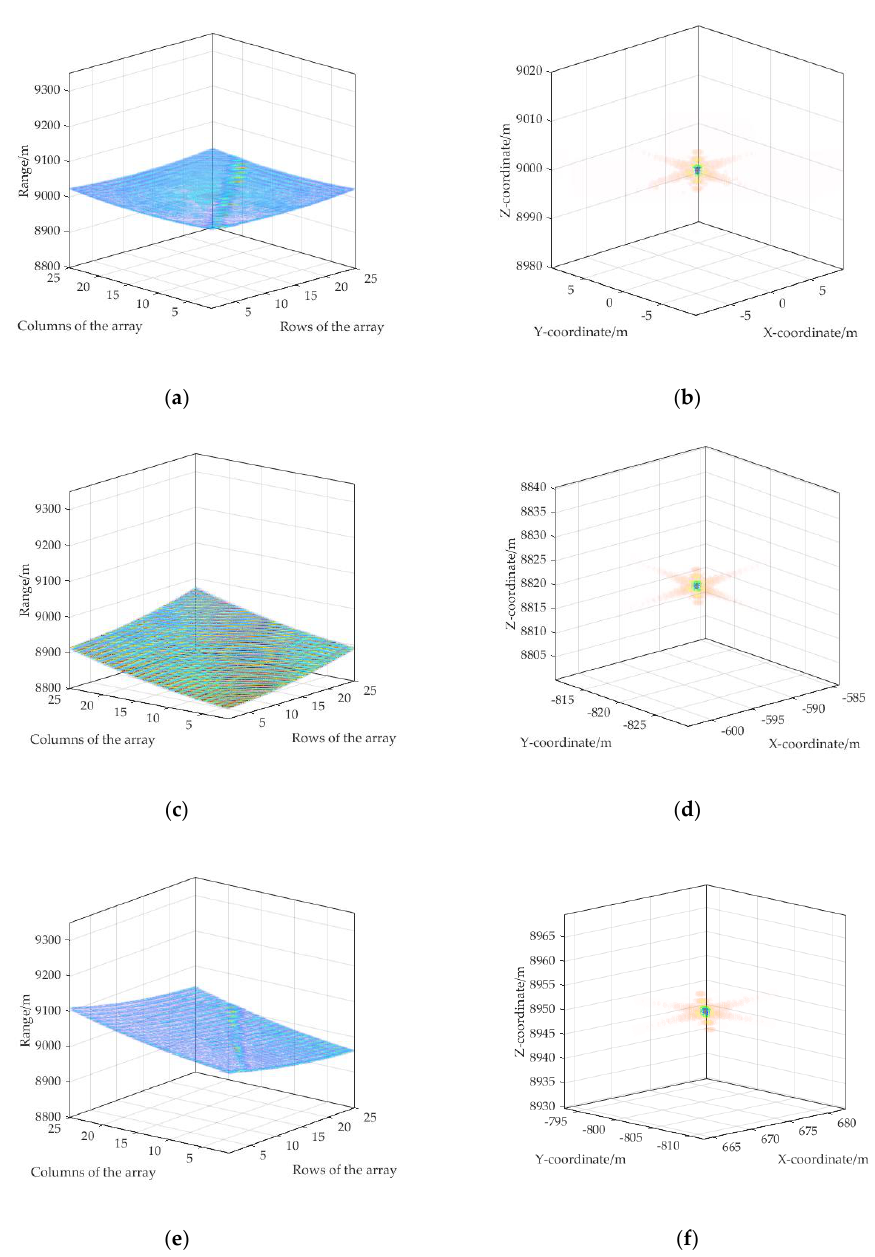
Figure 12. Results of multi-target range profile separation. ( a ) Range profile of target 1. ( b ) Imaging result of target 1. ( c ) Range profile of target 2. ( d ) Imaging result of target 2. ( e ) Range profile of target 3. ( f ) Imaging result of target 3.